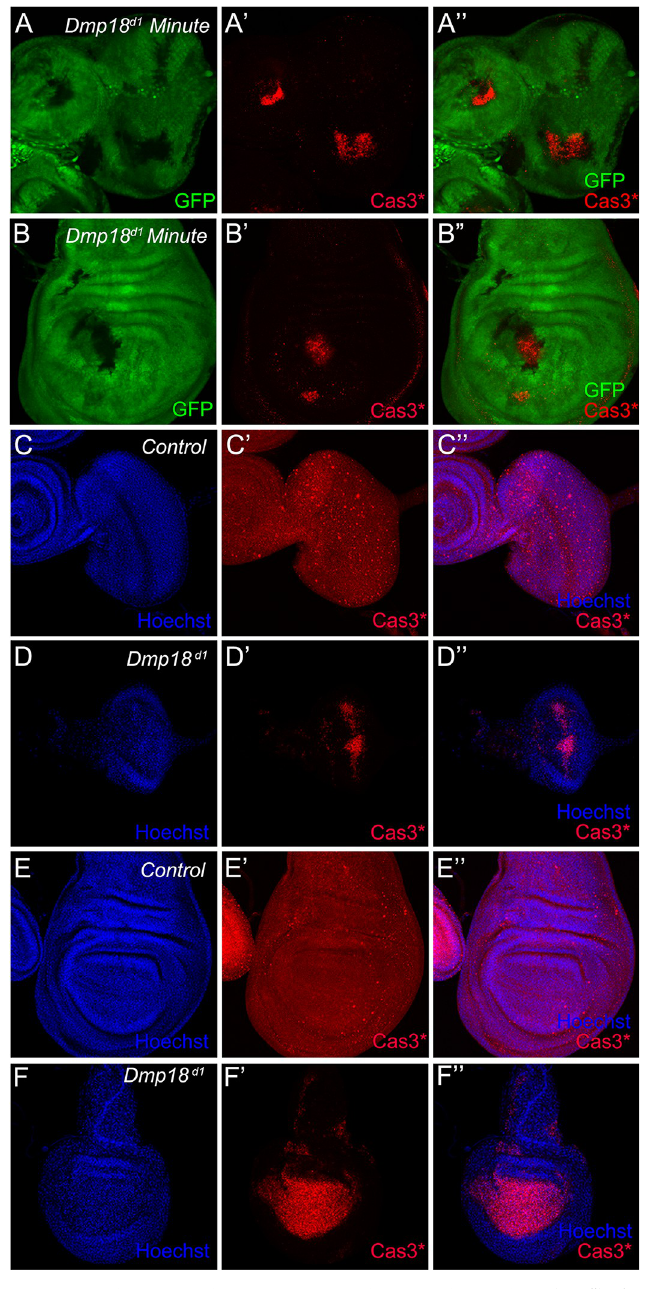
Fig 2. Loss of Dmp18 induces apoptosis in the eye and wing discs. (A-B”) The Cas3 � was increased in the Dmp18 mutant clones. GFP-free region marked the Dmp18 mutant clones. (C-D”) The Cas3 � was increased in the homozygous Dmp18 d1 eye disc (D-D”) compared to the control eye disc (C-C”). (E-F”) The Cas3 � was increased in the homozygous Dmp18 d1 wing pouch (F-F”) compared to the control wing disc (E-E”). Genotypes: A-B”: yw , hs-FLP/+; FRT 40A -M(2L)-Ubi-GFP/FRT 40A -Dmp18 d1 ; C-C” and E-E”: FRT 40A /FRT 40A ; D-D” and F-F”: FRT 40A -Dmp18 d1 / FRT 40A -Dmp18 d1